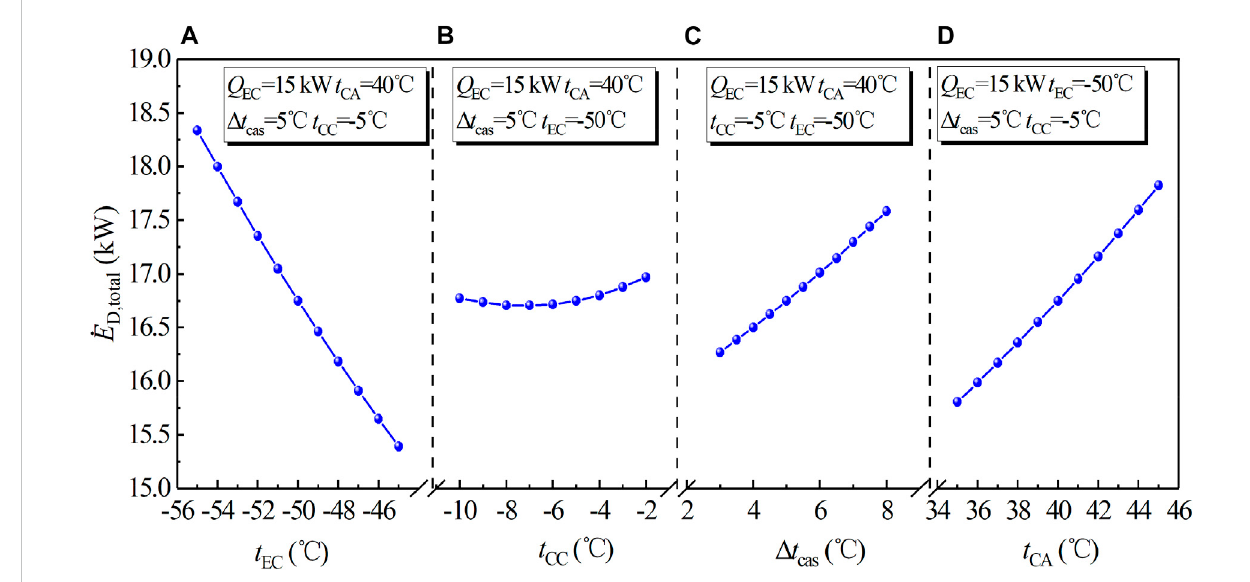
FIGURE 5 Variations of exergy destruction.